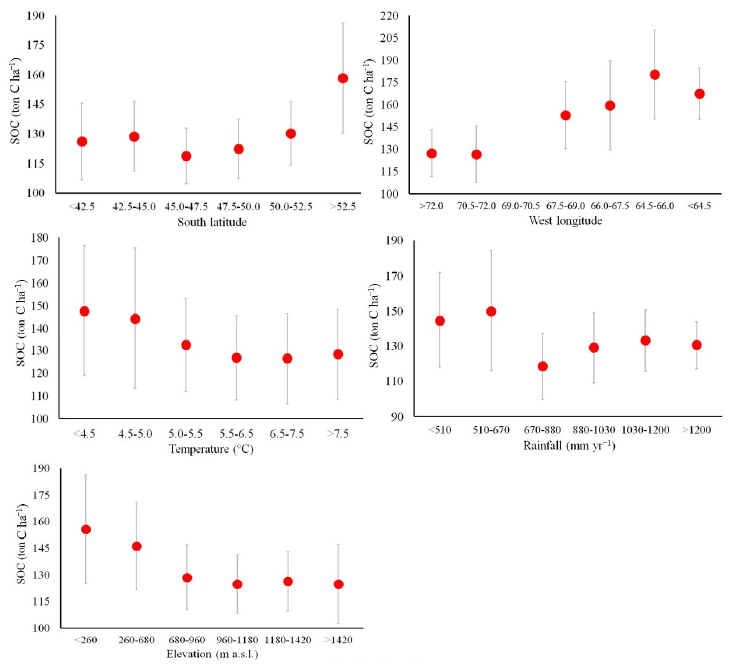
Figure A3. Soil organic carbon content (SOC) of the different Patagonian forest types in Argentina (see Table 1). The bars indicate the standard deviation.